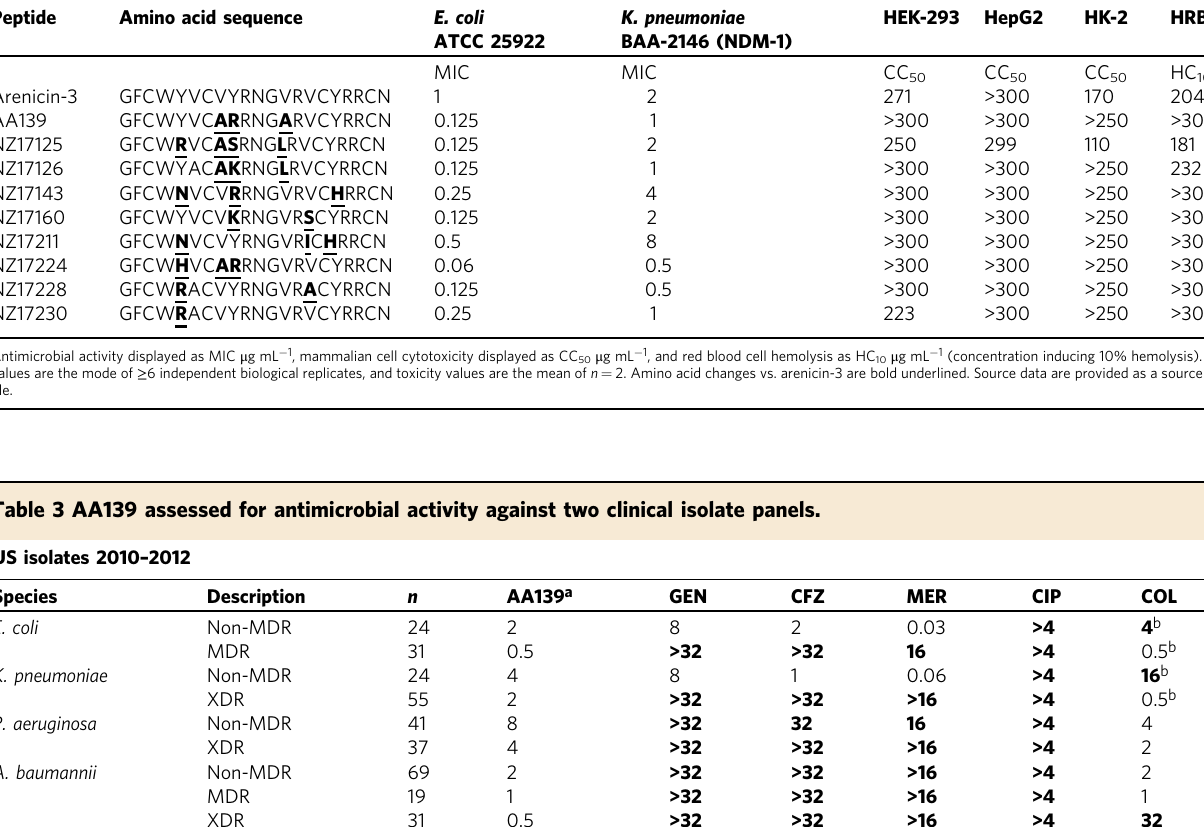
Table 2 Arenicin-3 and its analogs assessed for in vitro antimicrobial activity and toxicity.